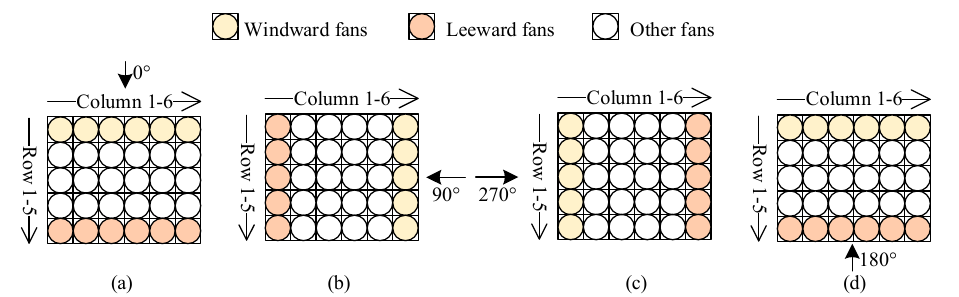
Figure 11. Schematic of divisional regulation of fan array under different wind directions: ( a ) in wind direction 0°; ( b ) in wind direction 90°; ( c ) in wind direction 270°; ( d ) in wind direction 180°. direction 0 ◦ ; ( b ) in wind direction 90 ◦ ; ( c ) in wind direction 270 ◦ ; ( d ) in wind direction 180 ◦ .